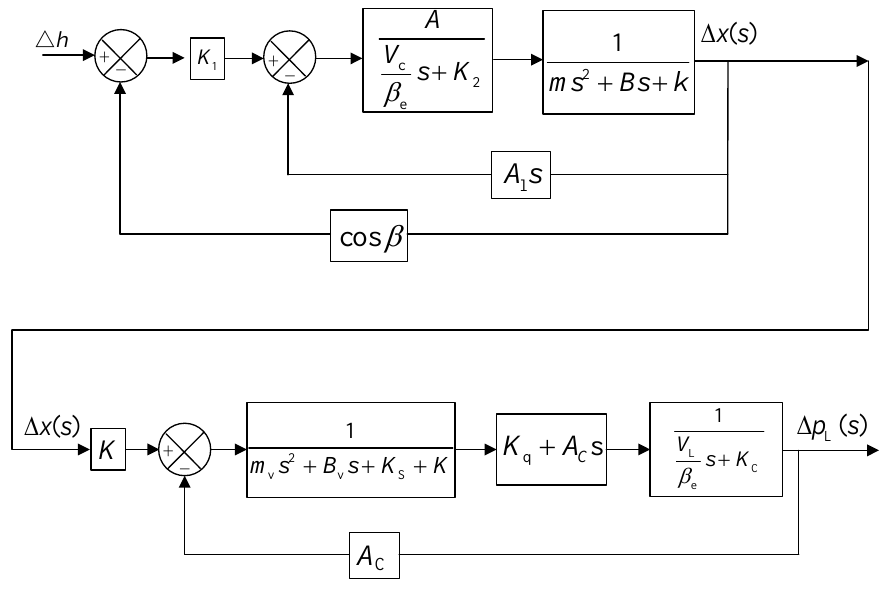
Figure 4. The 2D digital buffer valve transfer function block diagram.